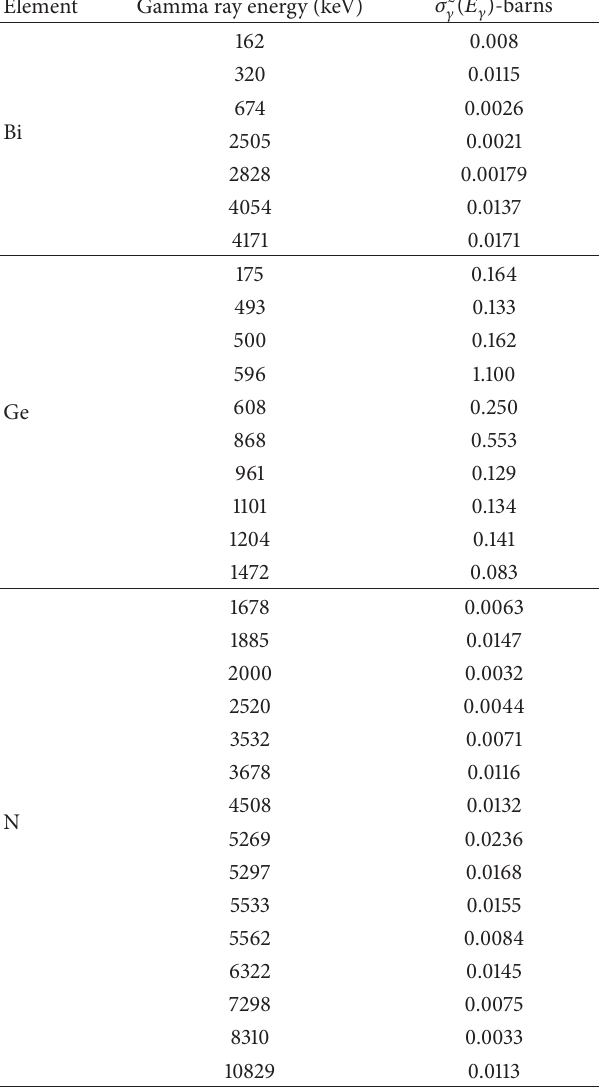
Table 2: Capture gamma rays energies and partial elemental cross section in bismuth, germanium and nitrogen [20].